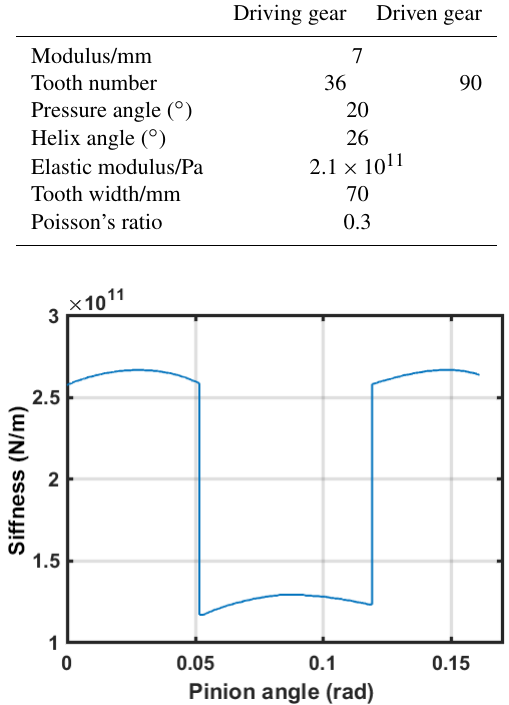
Figure 2. Time-varying mesh stiffness